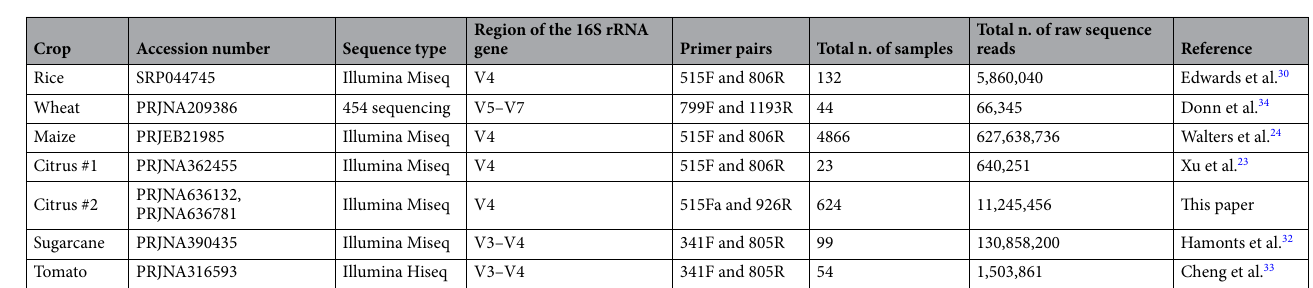
Table 1. Summary of the sequence data used in this study, including the accession number, sequence type, region of the 16S rRNA gene, total number of samples, and total number of raw sequence reads for each rhizobiome study.